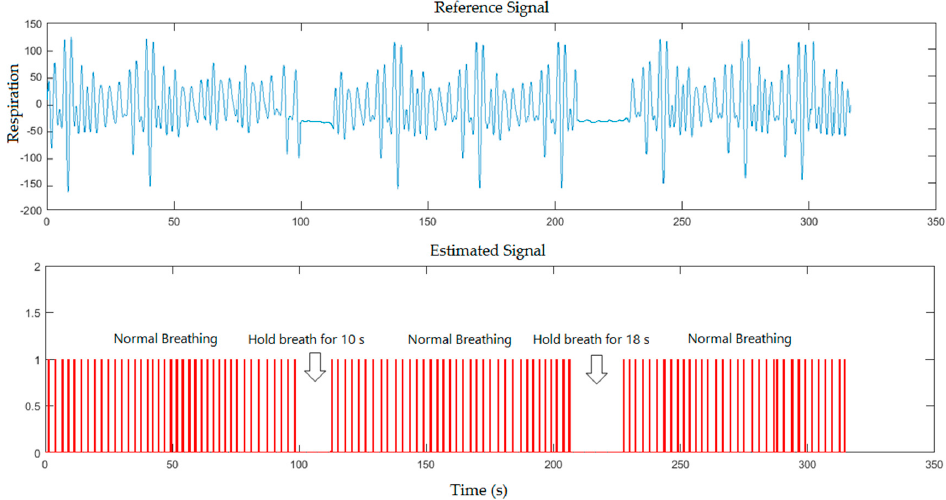
Figure 5. A five minutes simulation for healthy subject where the subject was asked to hold his breath twice during the measurement for the first scenario (without a blanket).